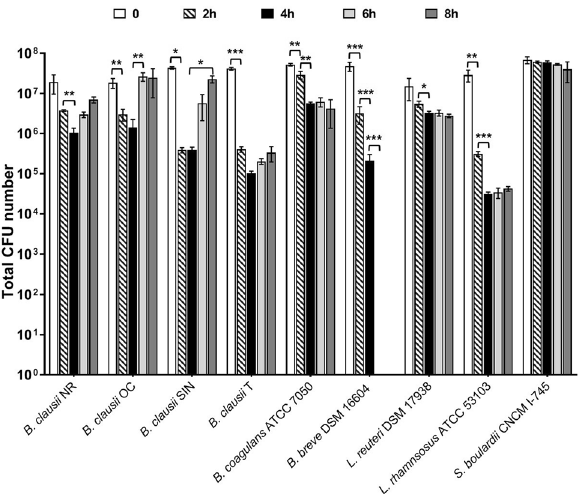
Figure 1. Survival of probiotic strains in simulated intestinal juice. Microbial counts (total CFU number) were performed at the inoculum (0, open bars) and after 2 (diagonally hatched bars), 4 (closed bars), 6 (light grey bars), and 8 (dark grey bars) hours of incubation at 37 °C. Three independent biological replicates with two technical replicates each were performed. Data are expressed as the mean ± standard deviation. For each